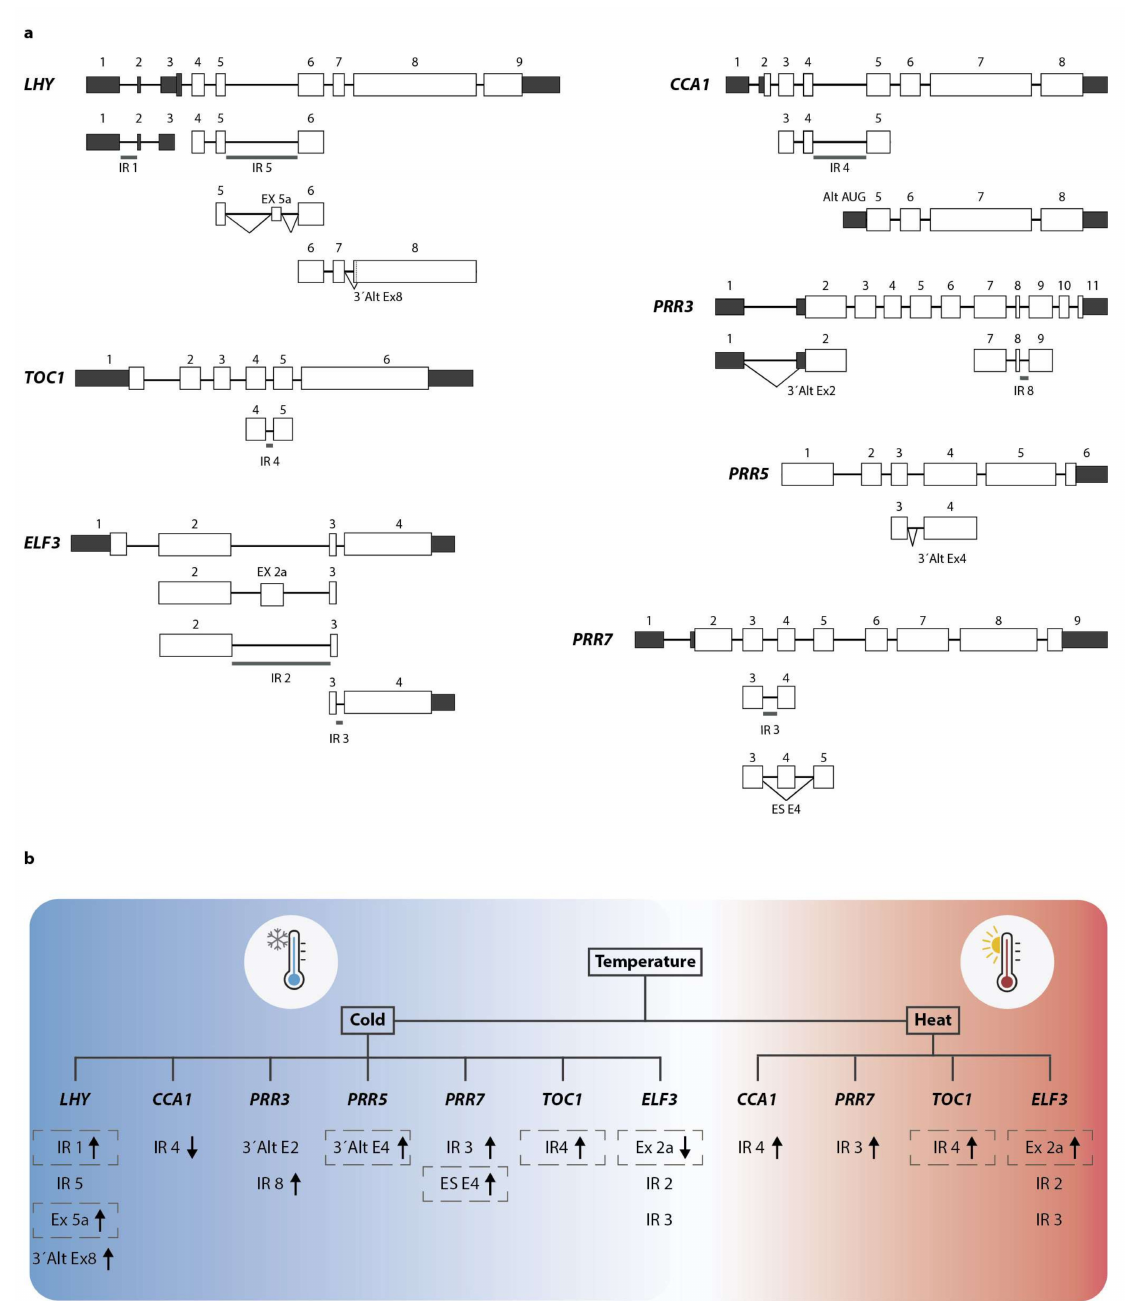
Figure 2. Temperature-regulated alternative splicing (AS) events in core clock genes. ( a ) Genomic structure of major clock components LHY , CCA1 , PRR3 , PRR5 , PRR7 , TOC1 , and ELF3 . White boxes depict coding exons and dark-shaded boxes represent 5 (cid:48) and 3 (cid:48) UTRs. Reported alternative spliced events are shown below each gene structure. Diagonal lines illustrate splicing events. IR: intron retention; ES: exon skipping; 3 (cid:48) Alt Ex: alternative start of exons. This figure was adapted from References [78,79]. ( b ) Summary of the current knowledge regarding temperature-induced AS of clock genes. Alternative transcripts are divided as cold-regulated or heat-regulated. Arrow lines represent the up- or downregulation of the events under each condition. Gray dashed boxes indicate AS events that result in the introduction of a PTC and consequently